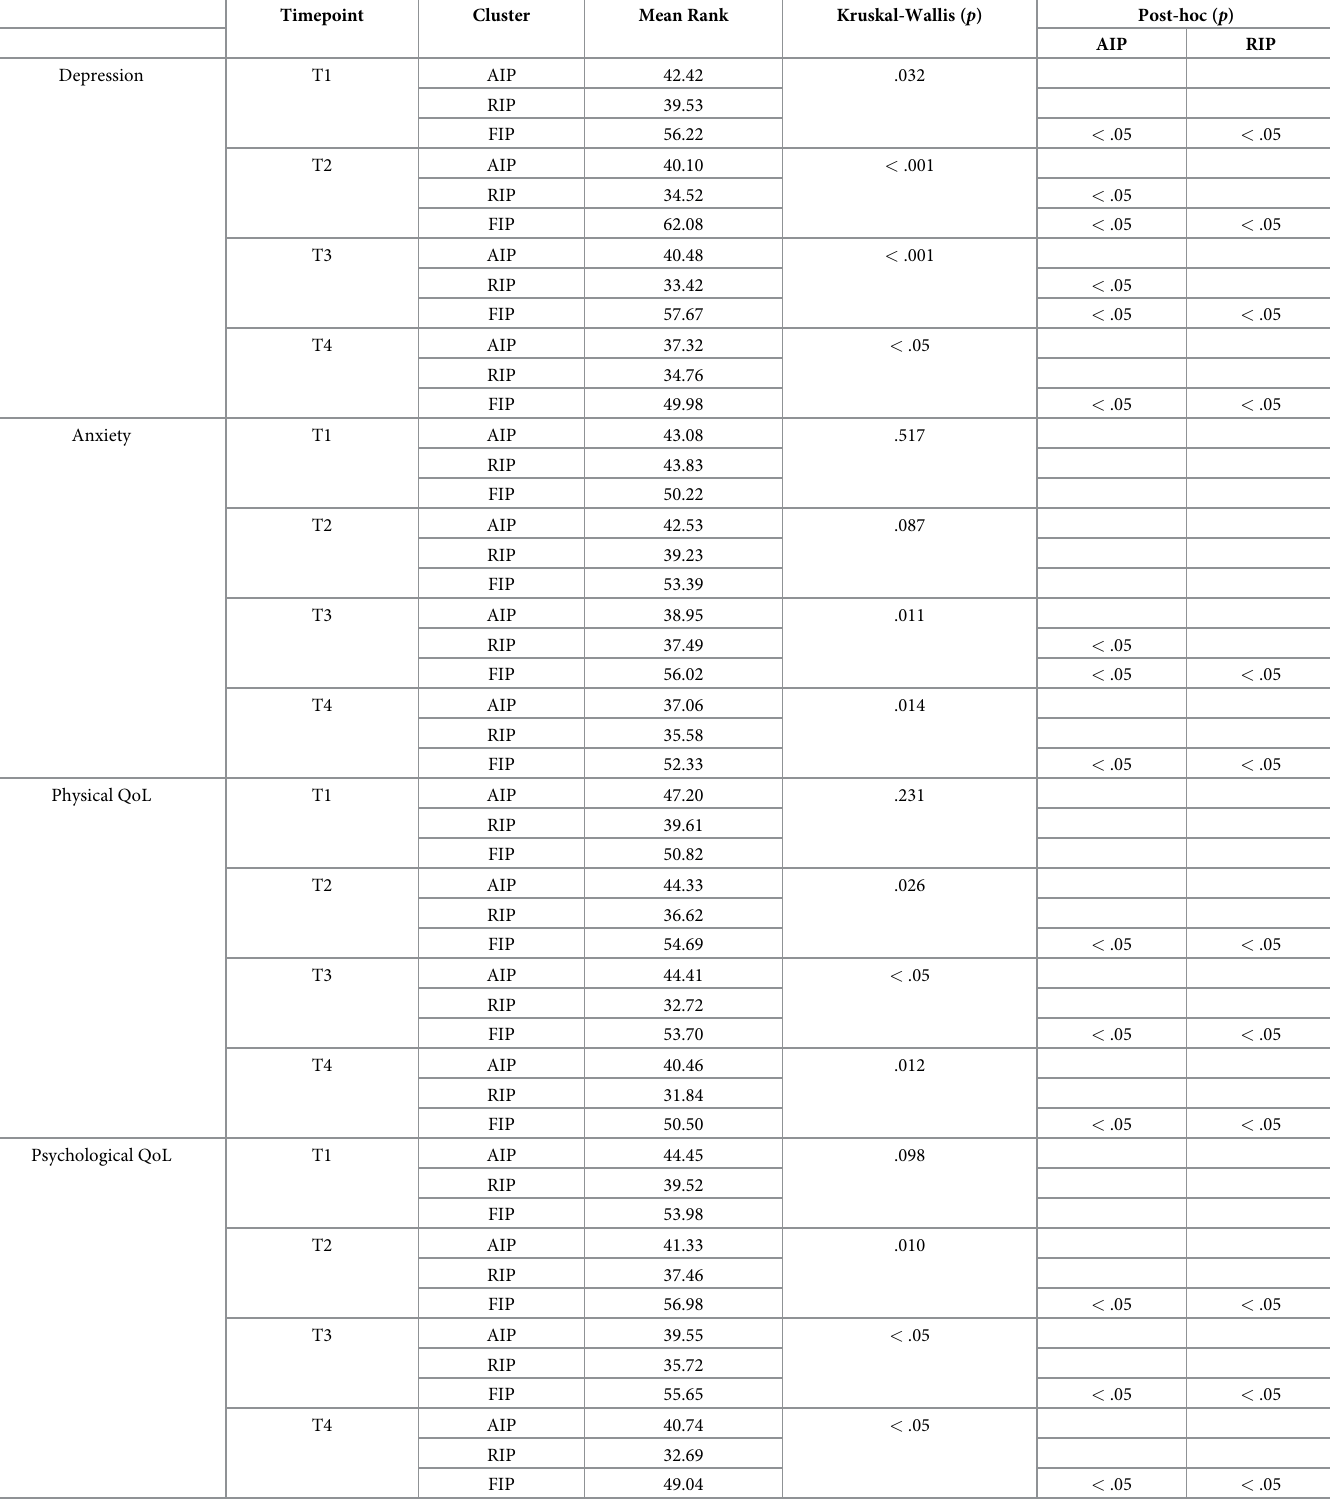
Table 6. Comparisons of aspects of adaptation between AIP, RIP and FIP